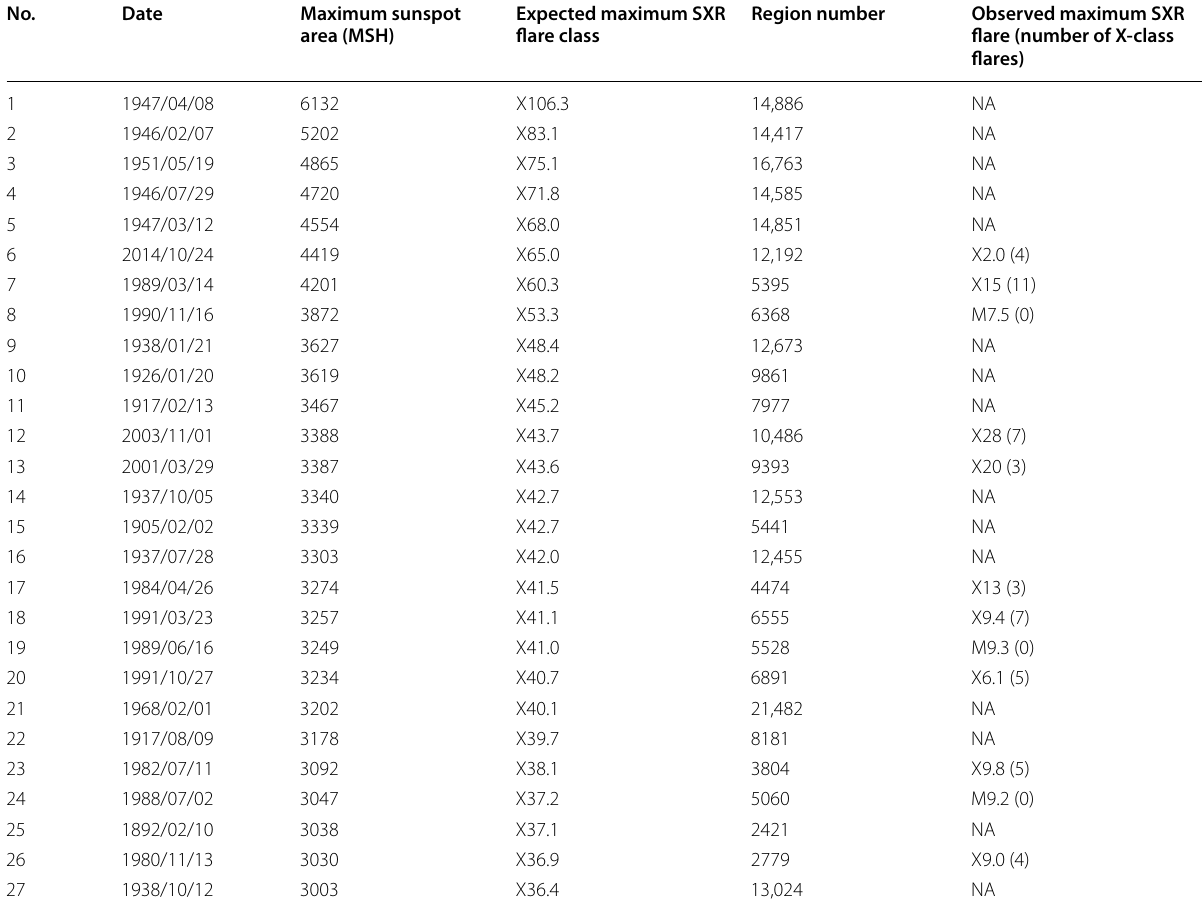
Table 1 Sunspot groups with maximum area of more than 3000 MSH and expected and observed maximum SXR flare class between 1879 and 2016 in the DHO